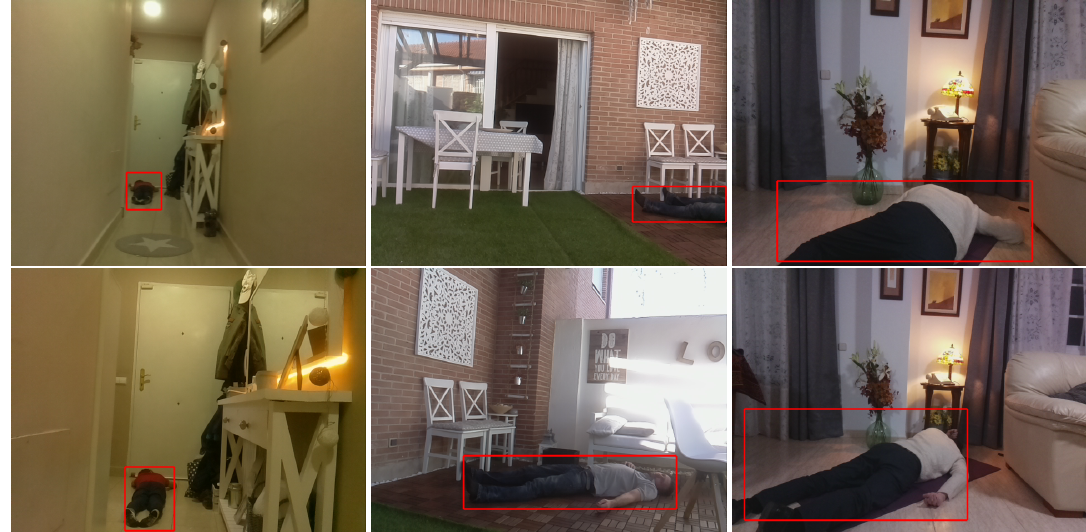
Figure 15. Robot relocation in three different testing examples of the FPDS dataset.